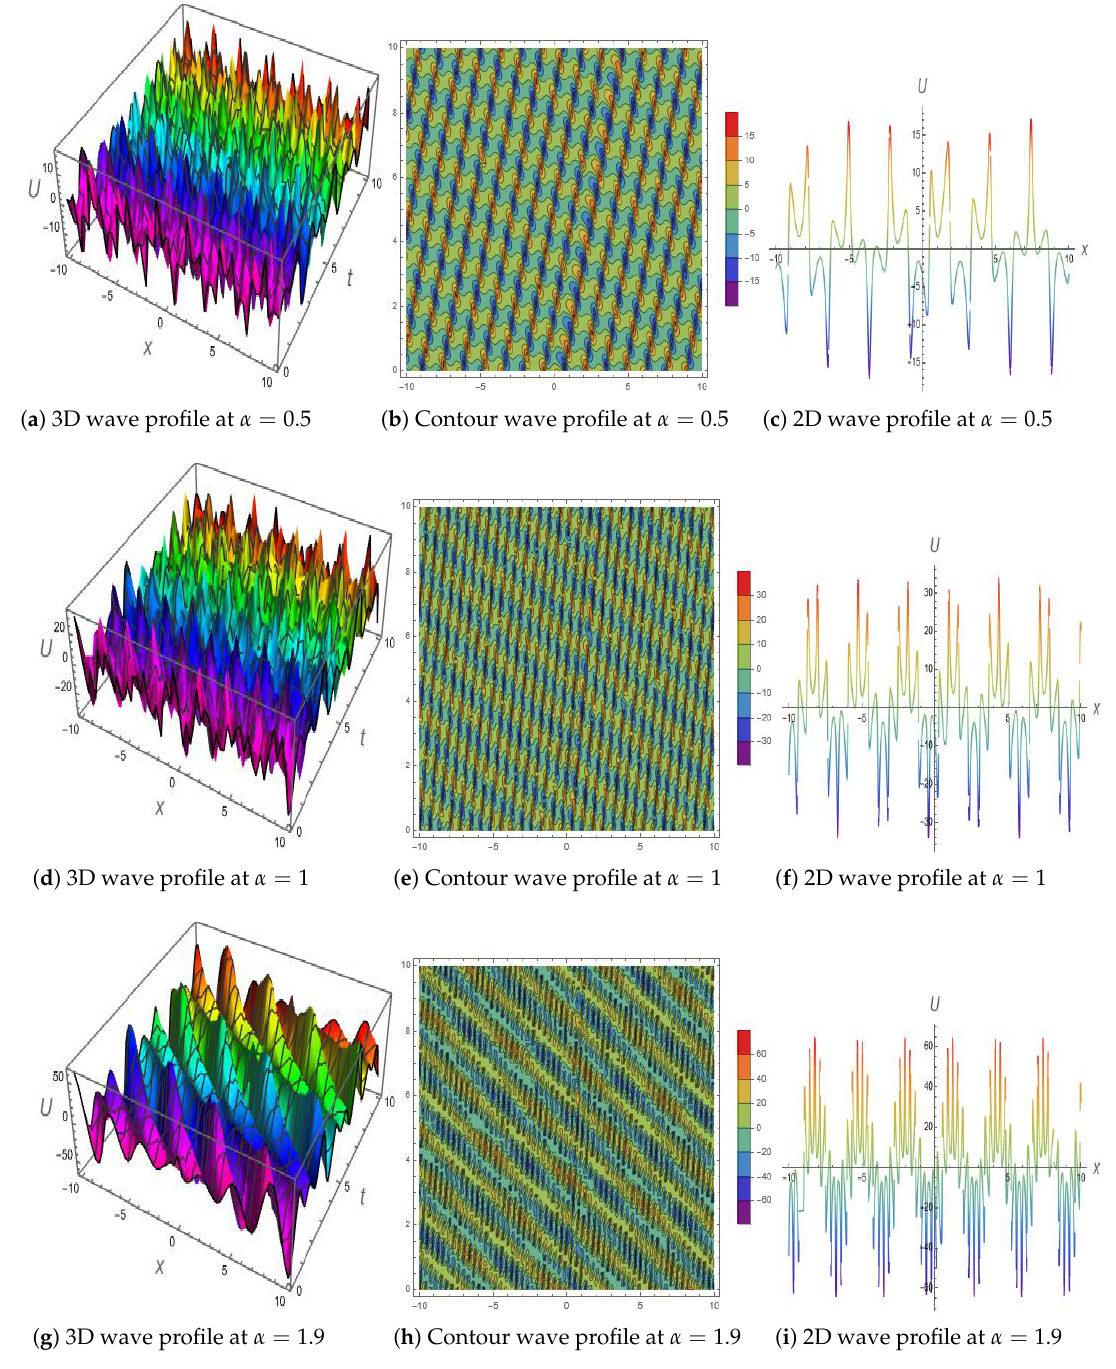
Figure 4. The effect of different wave numbers α on the Imaginary part of solution U 3